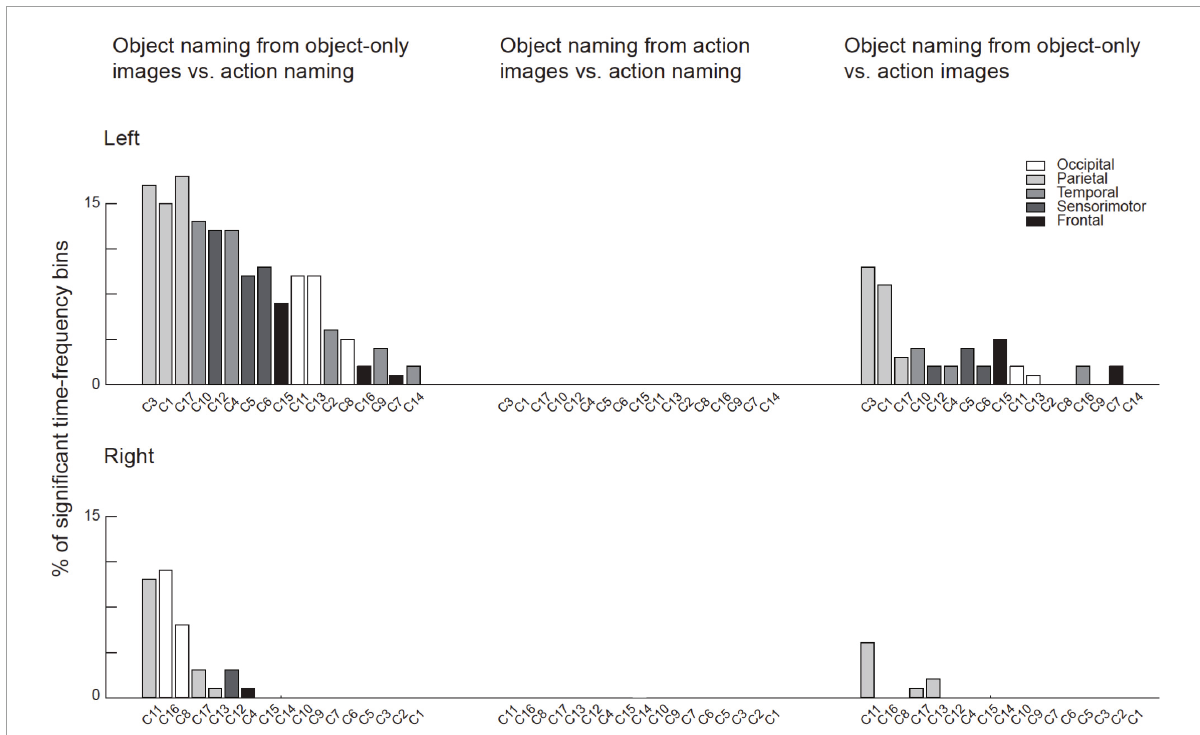
FIGURE7 Significant results in the MEG activation analysis for each cluster. For each cluster the number of significant time-frequency bins are indicated as the percentage of all possible time-frequency bins (in total 132 bins from 6 frequency bands and 22 time-windows). The bars are color-coded according to the lobe to which the majority of the parcels belong to. The clusters are ordered according to the total percentage of significant time-frequency bins in all tasks (left and right- hemispheres separately). Note that there were no significant differences between neural activity during Object naming from action images and action naming, whereas for the other two contrasts where the stimulus contents were different multiple clusters showed significant